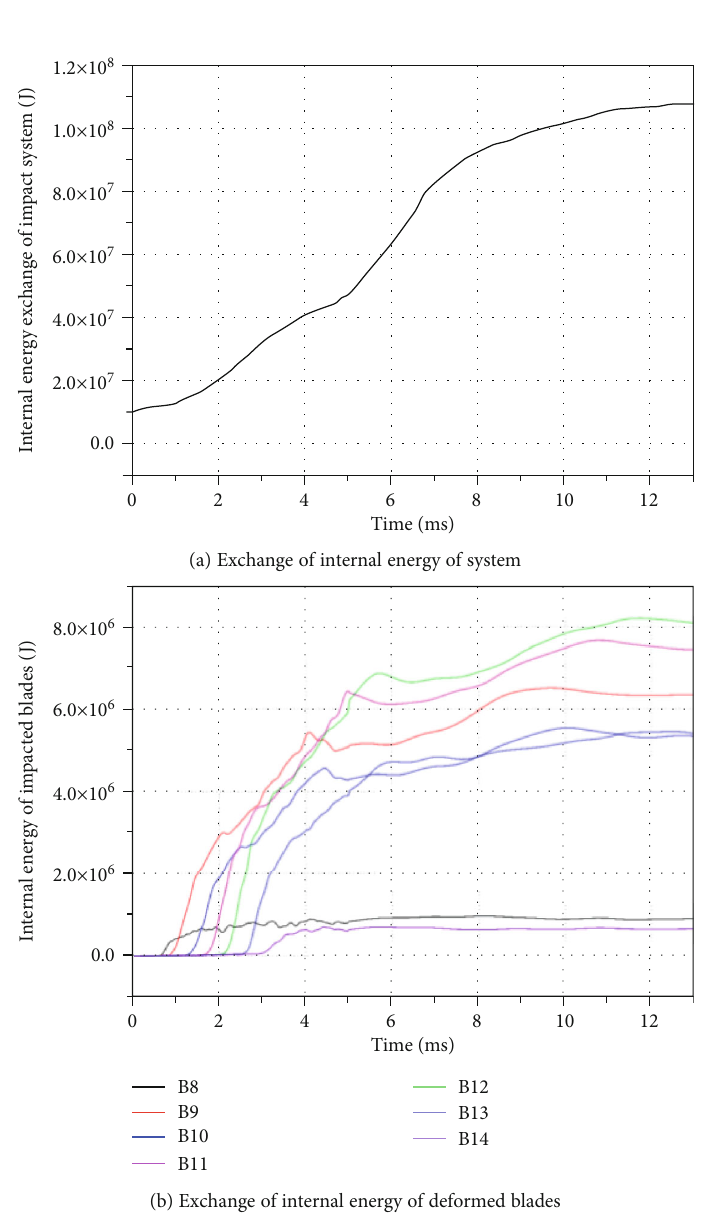
Figure 11: Exchange of system internal energy and blades ’ internal energy: (a) exchange of internal energy of system and (b) exchange of internal energy of deformed blades.